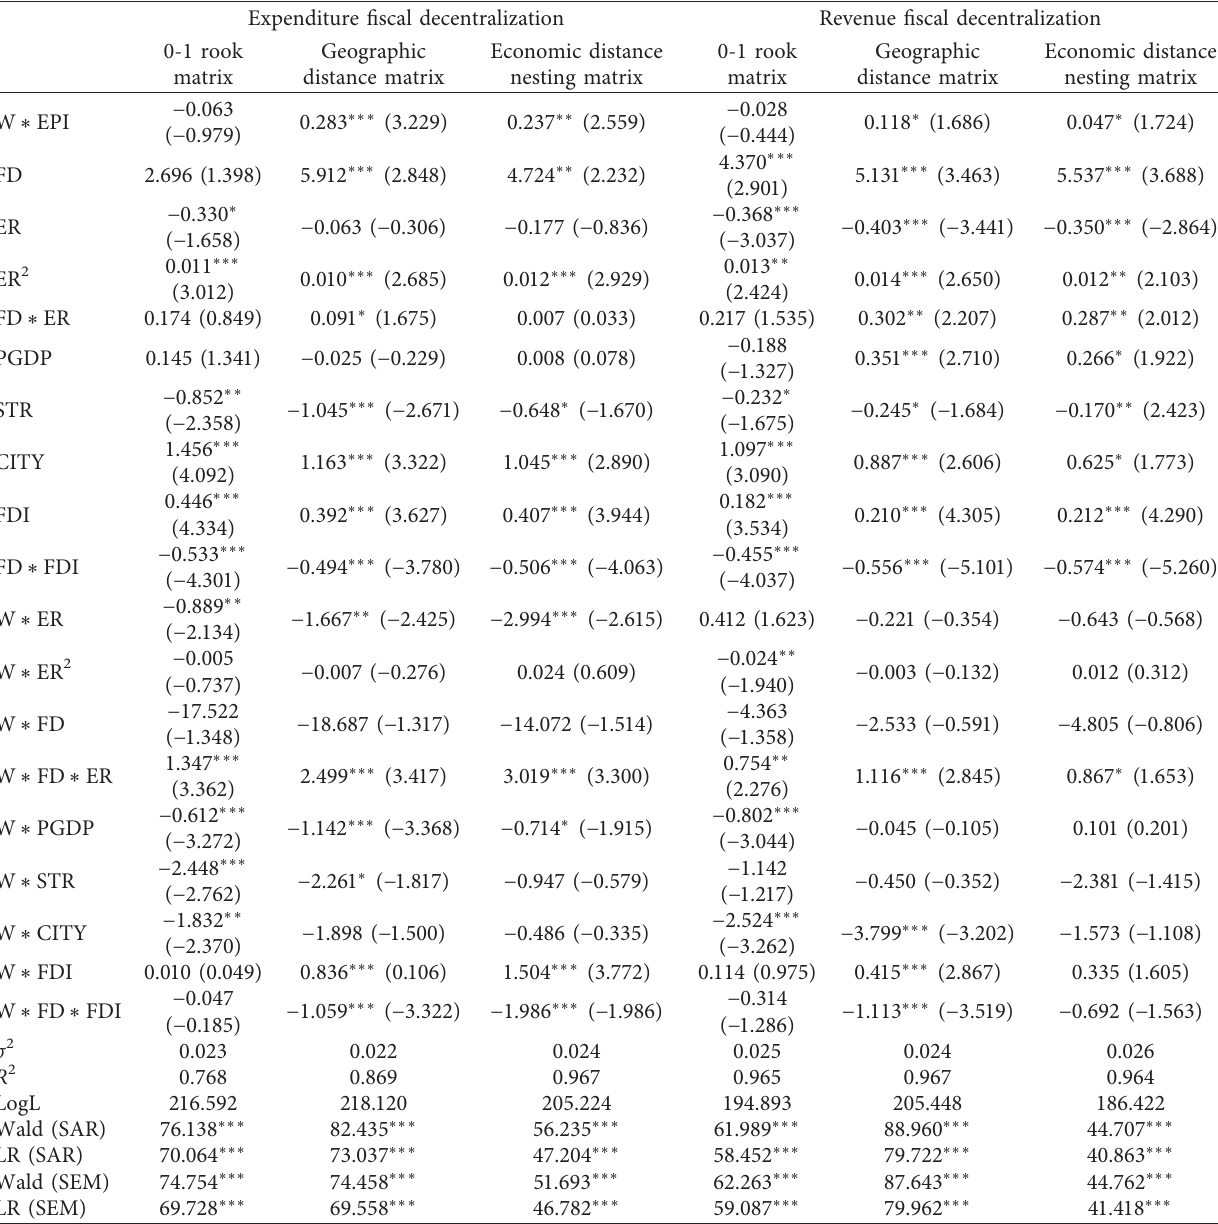
Table 5: Estimation results of the SDM